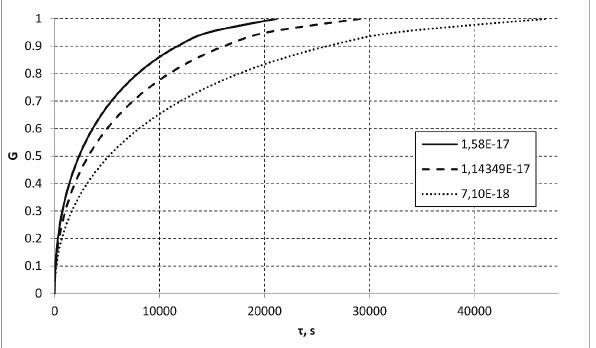
Figure 3: The effect of the nominal kinetic constant on conversion change in time (R = 1